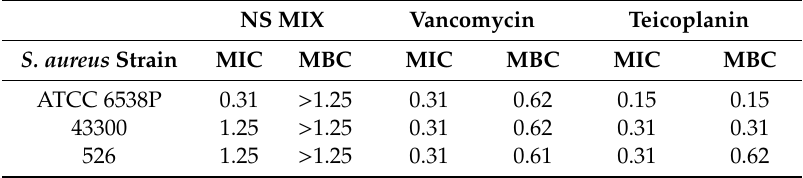
Table 1. MICs and MBCs of MIX (expressed as mg / ml) against S. aureus ATCC and clinical